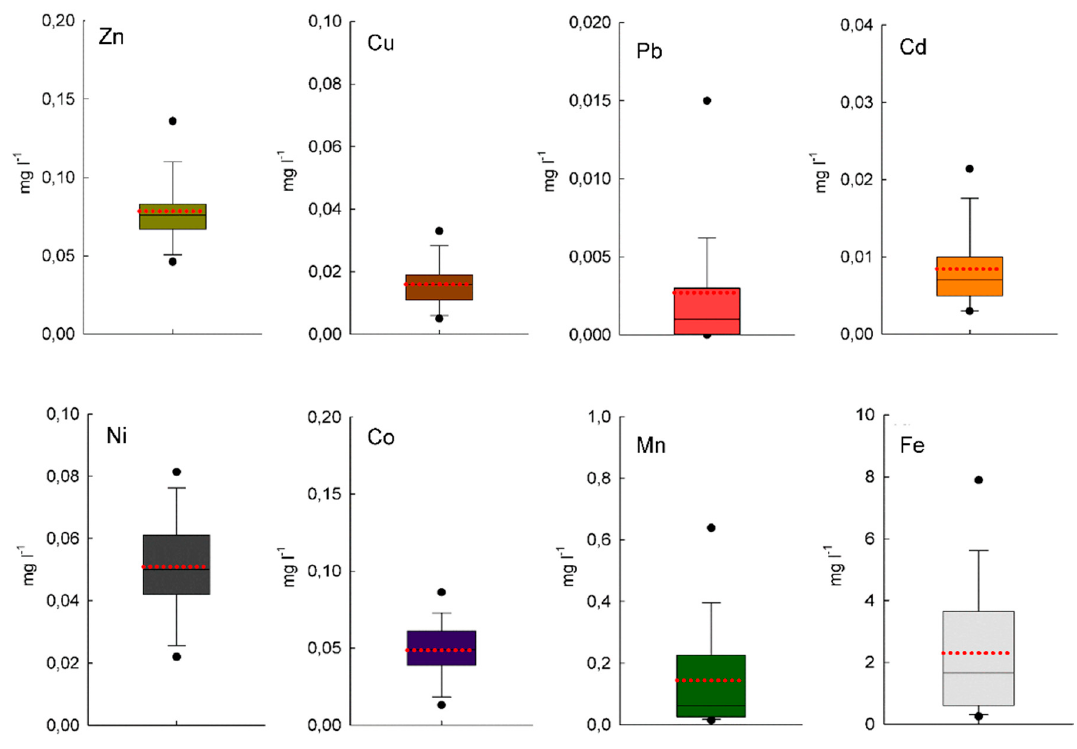
Figure 4. Heavy metal content.